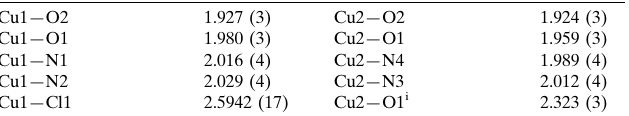
Selected bond lengths (A˚ ).